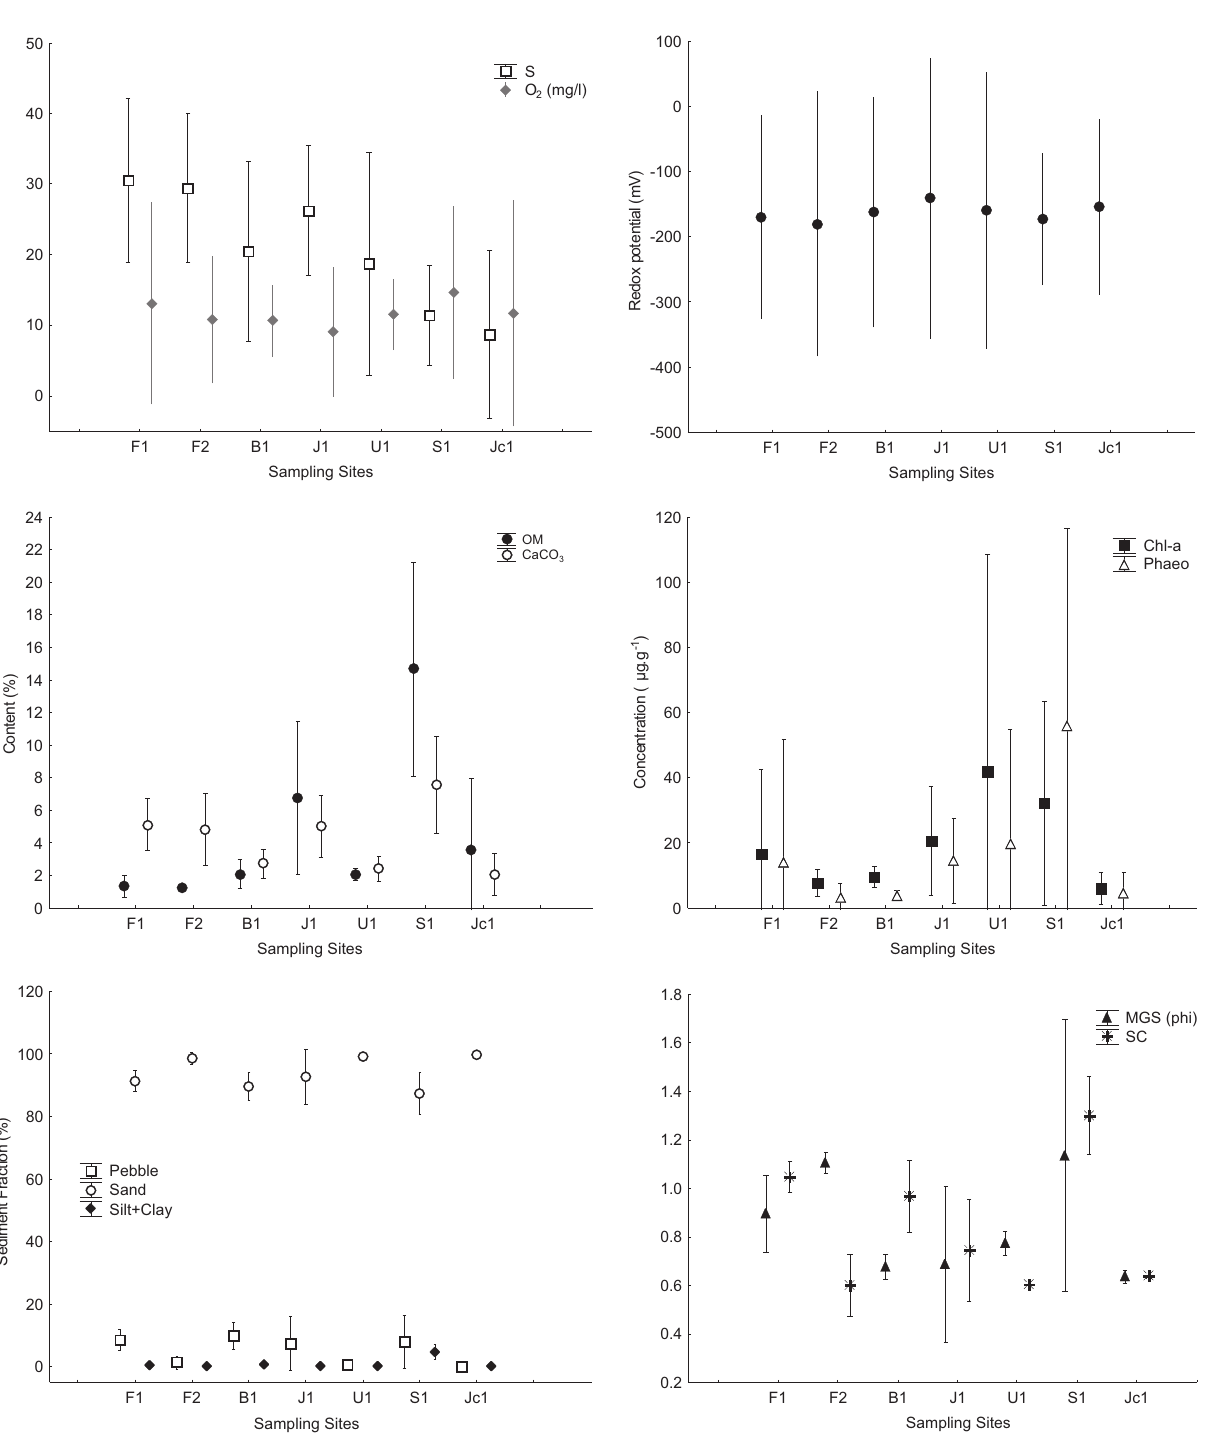
Figure 3. Mean and standard deviation of environmental variables per sampling site of Saquarema-Jaconé lagoonal system. (S) Salinity, (Eh) redox potential, (O2) dissolved oxygen, (OM) organic matter, (CaCO (MGS) mean grain size, (SC) sorting